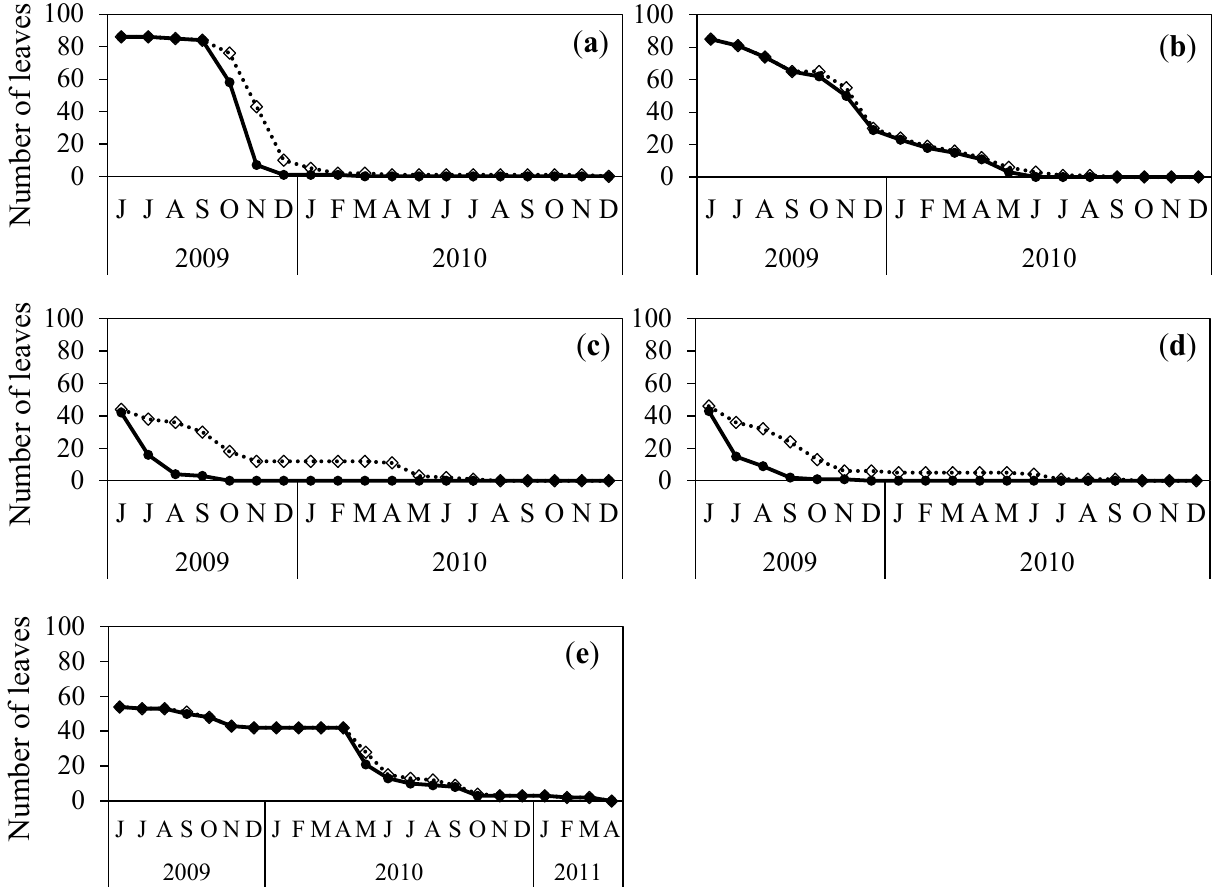
Figure 3. Timing of leaf fall and loss of green colour for five species of Rhododendron from SW China grown in Edinburgh; the numbers of leaves in marked cohorts were followed from their second summer; in each graph, the upper line is for green leaves plus non-green leaves and the lower for green leaves. ( a ) R. rubiginosum ; ( b ) R. pubescens ; ( c ) R. wallichii ; ( d ) R. wardii and ( e ) R. decorum